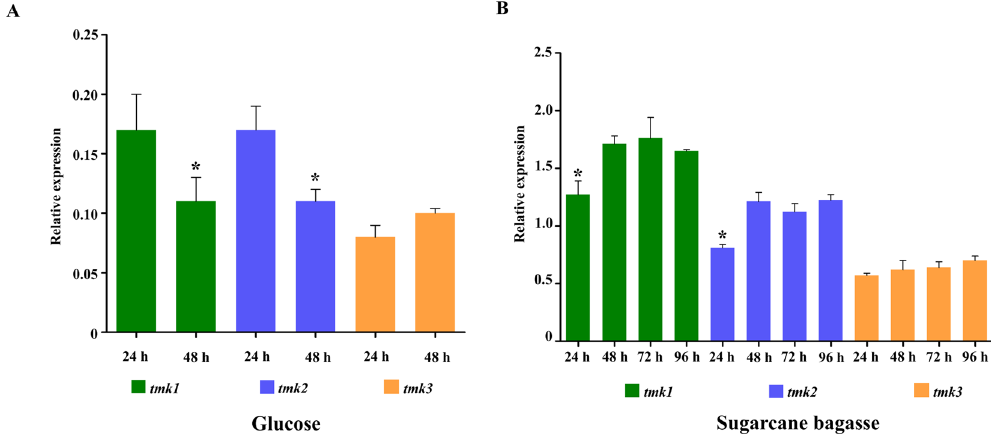
Figure 1. Expression profile of MAPK genes in the QM6a parental strain grown in sugarcane bagasse and glucose. ( A ) Relative expression of tmk1, tmk2 , and tmk3 upon growth in glucose. Expression levels were calibrated according to the comparative 2 −Δ Ct method, using the constitutively expressed gene β -actin as an endogenous control (ANOVA followed by Tukey’s pairwise comparison P < 0.05). * Significantly different from 24 h (P < 0.05). ( B ) Relative expression of tmk1, tmk2 , and tmk3 in the presence of sugarcane bagasse. Expression levels were calibrated according to the comparative 2 −ΔΔ Ct method, using the constitutively expressed gene β -actin as an endogenous control and glycerol samples the reference group (ANOVA followed by Tukey’s pairwise comparison P < 0.0001). * Significantly different from 48 h, 72 h, and 96 h (P < 0.0001). These results are based on three replicates of three independent experiments and are expressed as mean ± standard